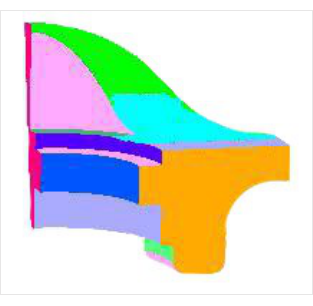
Figure 9. Result of feature surface extraction based on the fandisk model.